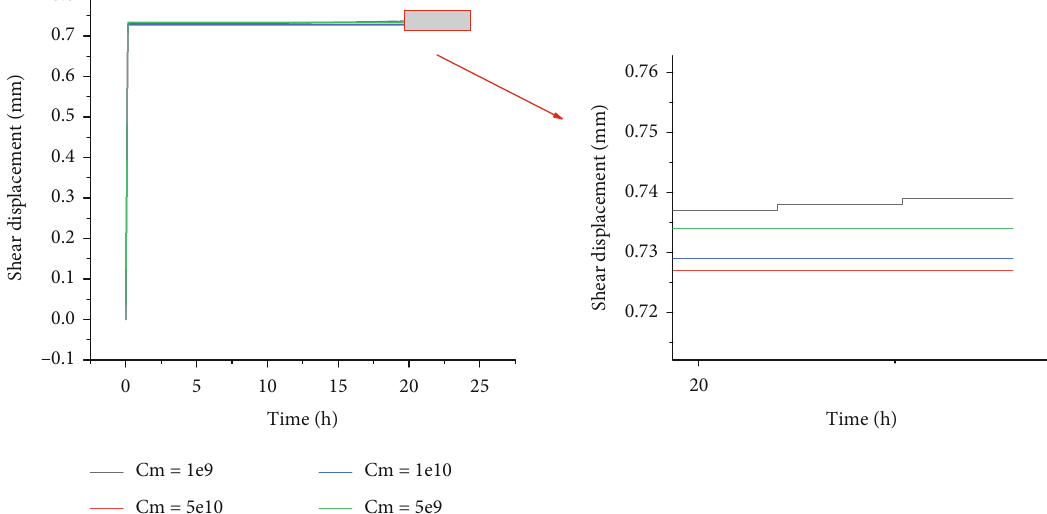
Figure 7: Shear displacement-time curves of bolted joints at di ff erent C